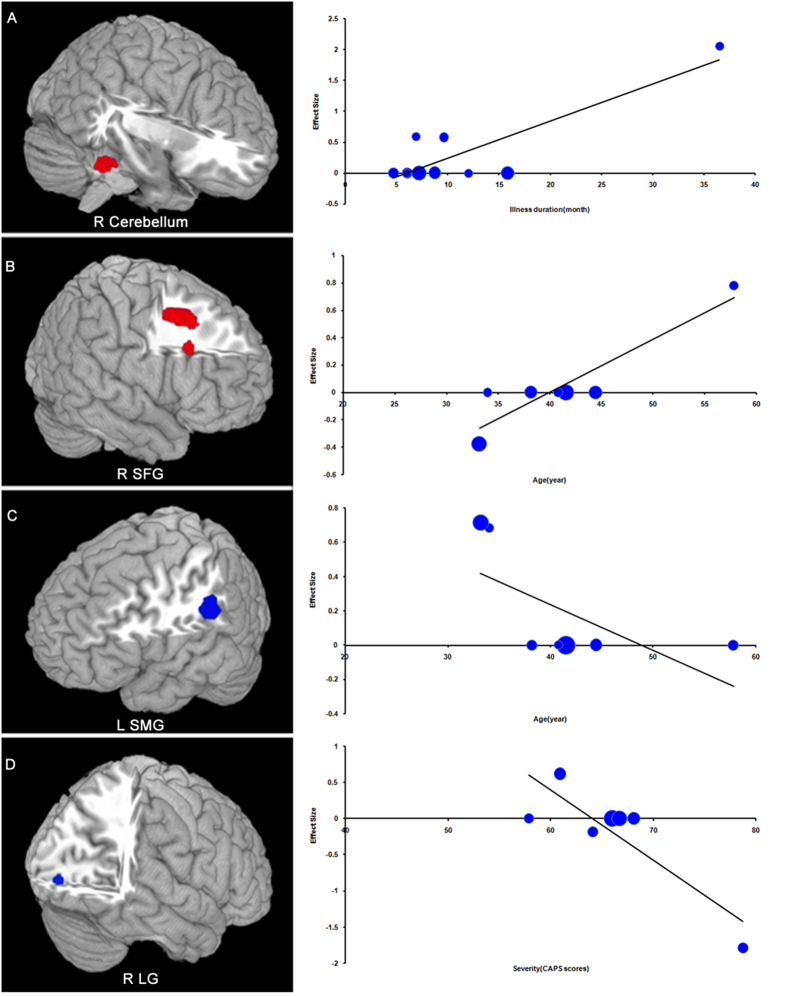
Results of meta-regression analyses of studies of PTSD patients compared with NTC (A) and TEC (B–D). (A) Illness duration is positively associated with the resting-state activity in the L cerebellum; (B) Mean patient age is positively associated with resting-state activity in the R SFG; (C) Mean age is negatively associated with resting-state activity in the L SMG; (D) Illness severity is negatively associated with resting-state activity in the R LG. Each study is represented as a dot, with larger dots symbolizing larger sample sizes. The regression line (meta-regression signed differential mapping slope) is shown as a straight line. R, right; L, left; SFG, superior frontal gyrus; SMG, supramarginal gyrus; LG, lingual gyrus; PTSD, posttraumatic stress disorder; NTC, non-traumatized controls; TEC, trauma-exposed controls.